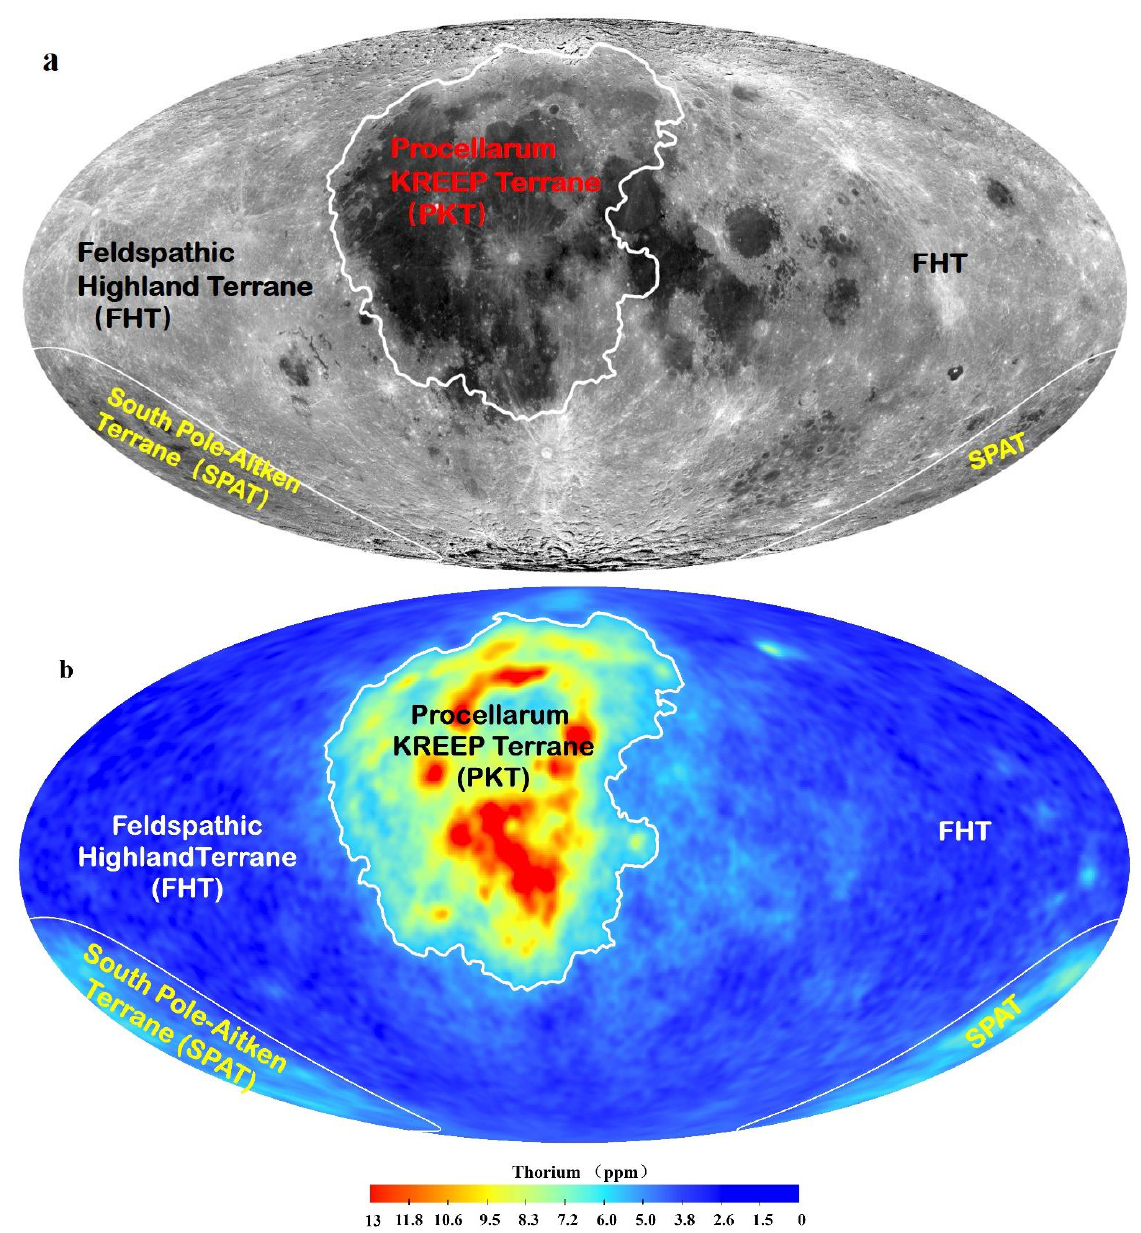
Figure 1. Maps showing the three lunar terranes. ( a ) CE-1 global lunar image map (from CE-1 CCD stereo camera DOM-120 m lunar image data). ( b ) Global thorium abundance from Lunar Prospector (LP) gamma-ray spectrometer data (Reprinted/adapted with permission from Ref. [11]. 1998, Lawrence, D.J.) overlain on LOLA hillshade map (Reprinted/adapted with permission from Ref. [40]. 2010, Smith, D.E.). South Pole–Aitken Terrane (SPAT) is marked with white solid line, Procellarum KREEP Terrane (PKT) boundary (red line) is denoted by the contour corresponding to a thorium value of 3 ppm (Reprinted/adapted with permission from Ref. [9]. 2000, Jolliff). Maps are plotted in Mollweide Projection.